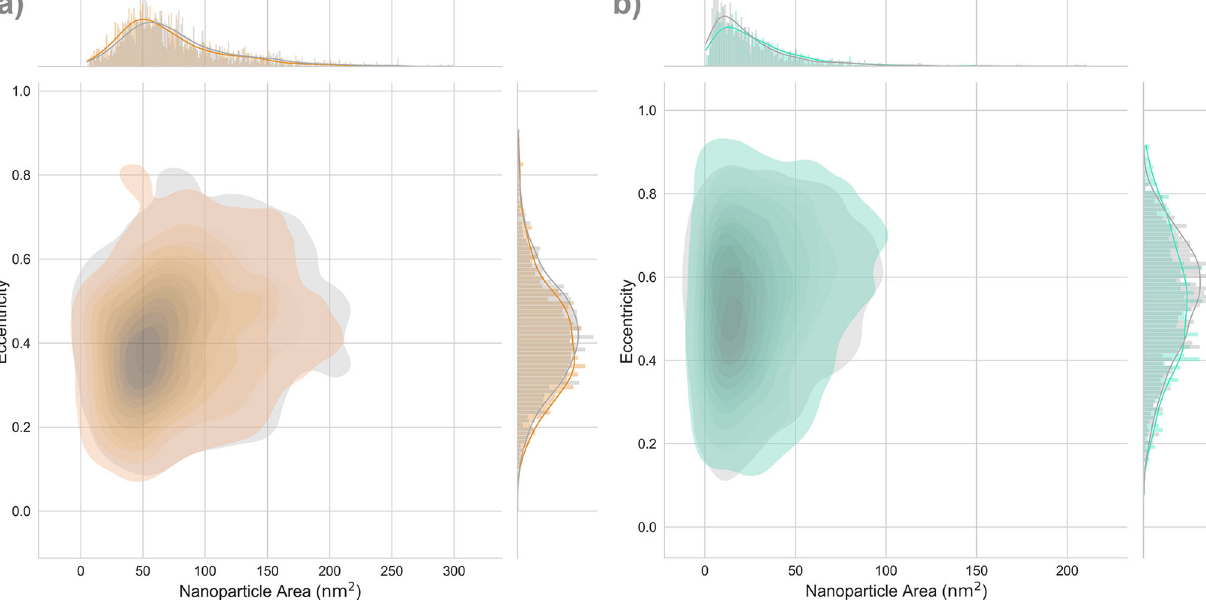
Fig. 9 Bivariate histograms with KDE-plots of nanoparticle area against eccentricity. Histograms were binned at 1 nm 2 ∙ bin − 1 for the nanoparticle area and at 0.01 ∙ bin − 1 for eccentricity. All KDE-plots were obtained using Gaussian kernels and Scott ’ s rule 53 a Au/Ge sub- datasets with F1-scores >0.8. b Pd/C sub-datasets with F1-scores >0.7.